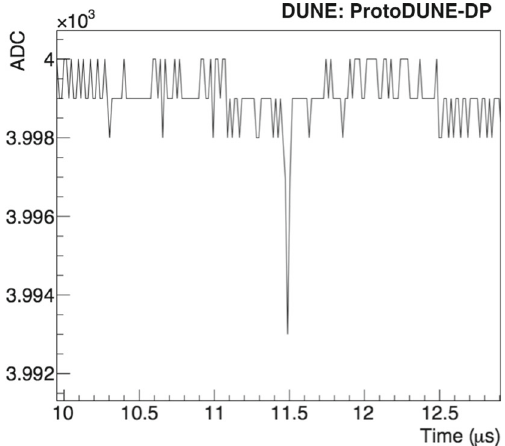
Fig. 8 Mean SPE amplitude from Gaussian fits as a function of the PMT gain, and linear fit. All PMTs are included but only data corre-